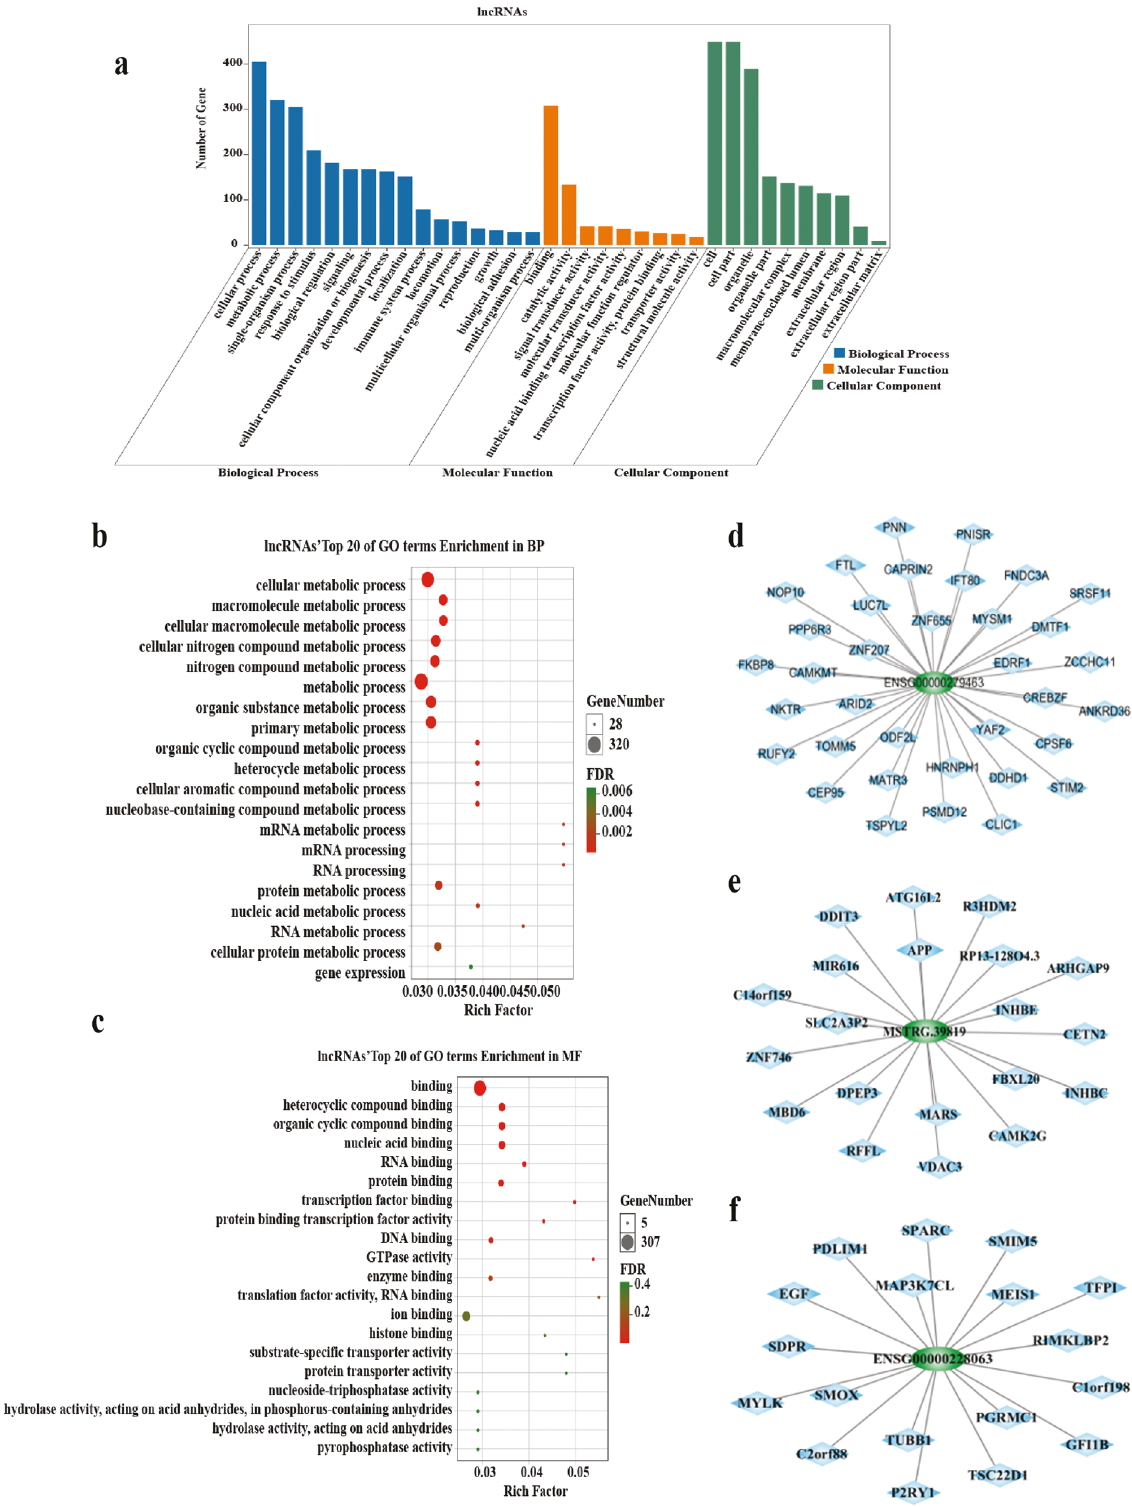
Fig. 2 Bioinformatic analysis via enrichment analysis of GO terms for DMC-lncRNAs and co-expression networks for DMC-lncRNAs and mRNAs. a GO analysis of DMC-lncRNAs within biological processes, molecular functions, and cellular components. b The top 20 GO terms of lncRNAs enriched in biological processes. c The top 20 GO terms of lncRNAs enriched in molecular function. d – f The co-expression network of 3 lncRNAs including ENSG00000279463, MSTRG.39819 and